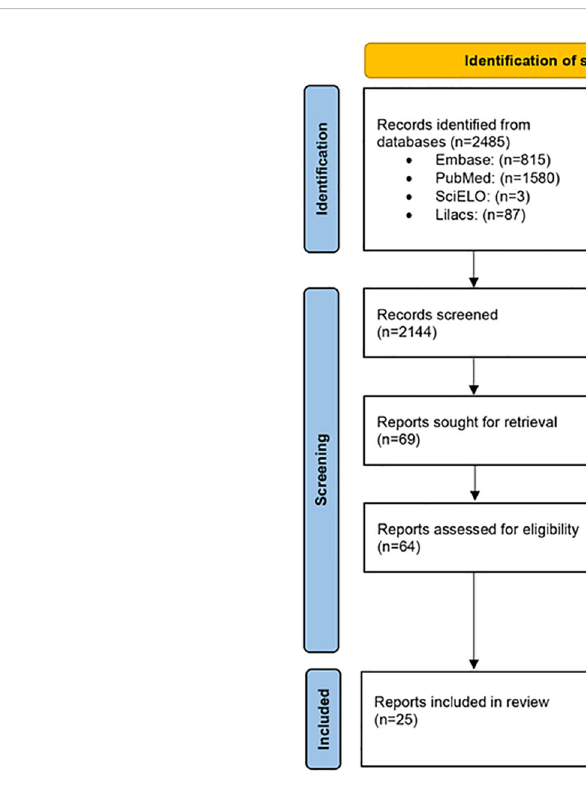
FIGURE 1 Flow diagram of the systematic selection of studies including in this